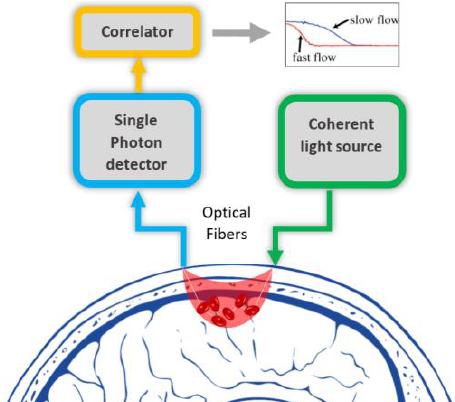
Figure 2. A typical diffuse correlations spectroscopy (DCS) setup uses a long coherent laser, single photon detectors and correlator.